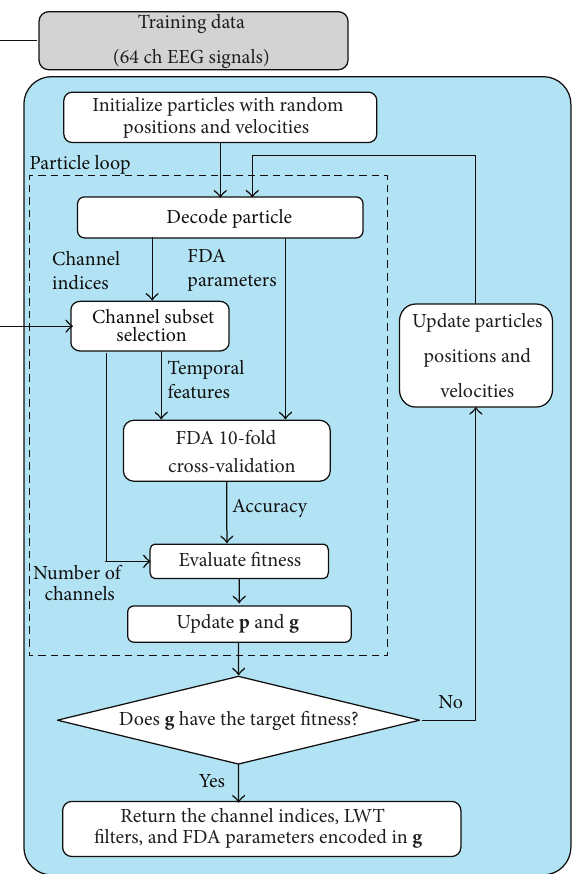
Figure 1: Flowchart of the proposed